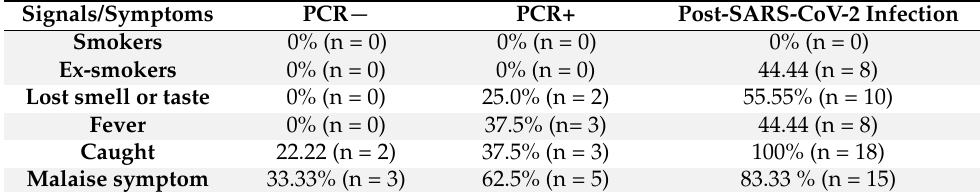
Table 1. Characteristics, signals, and symptoms of included subjects.